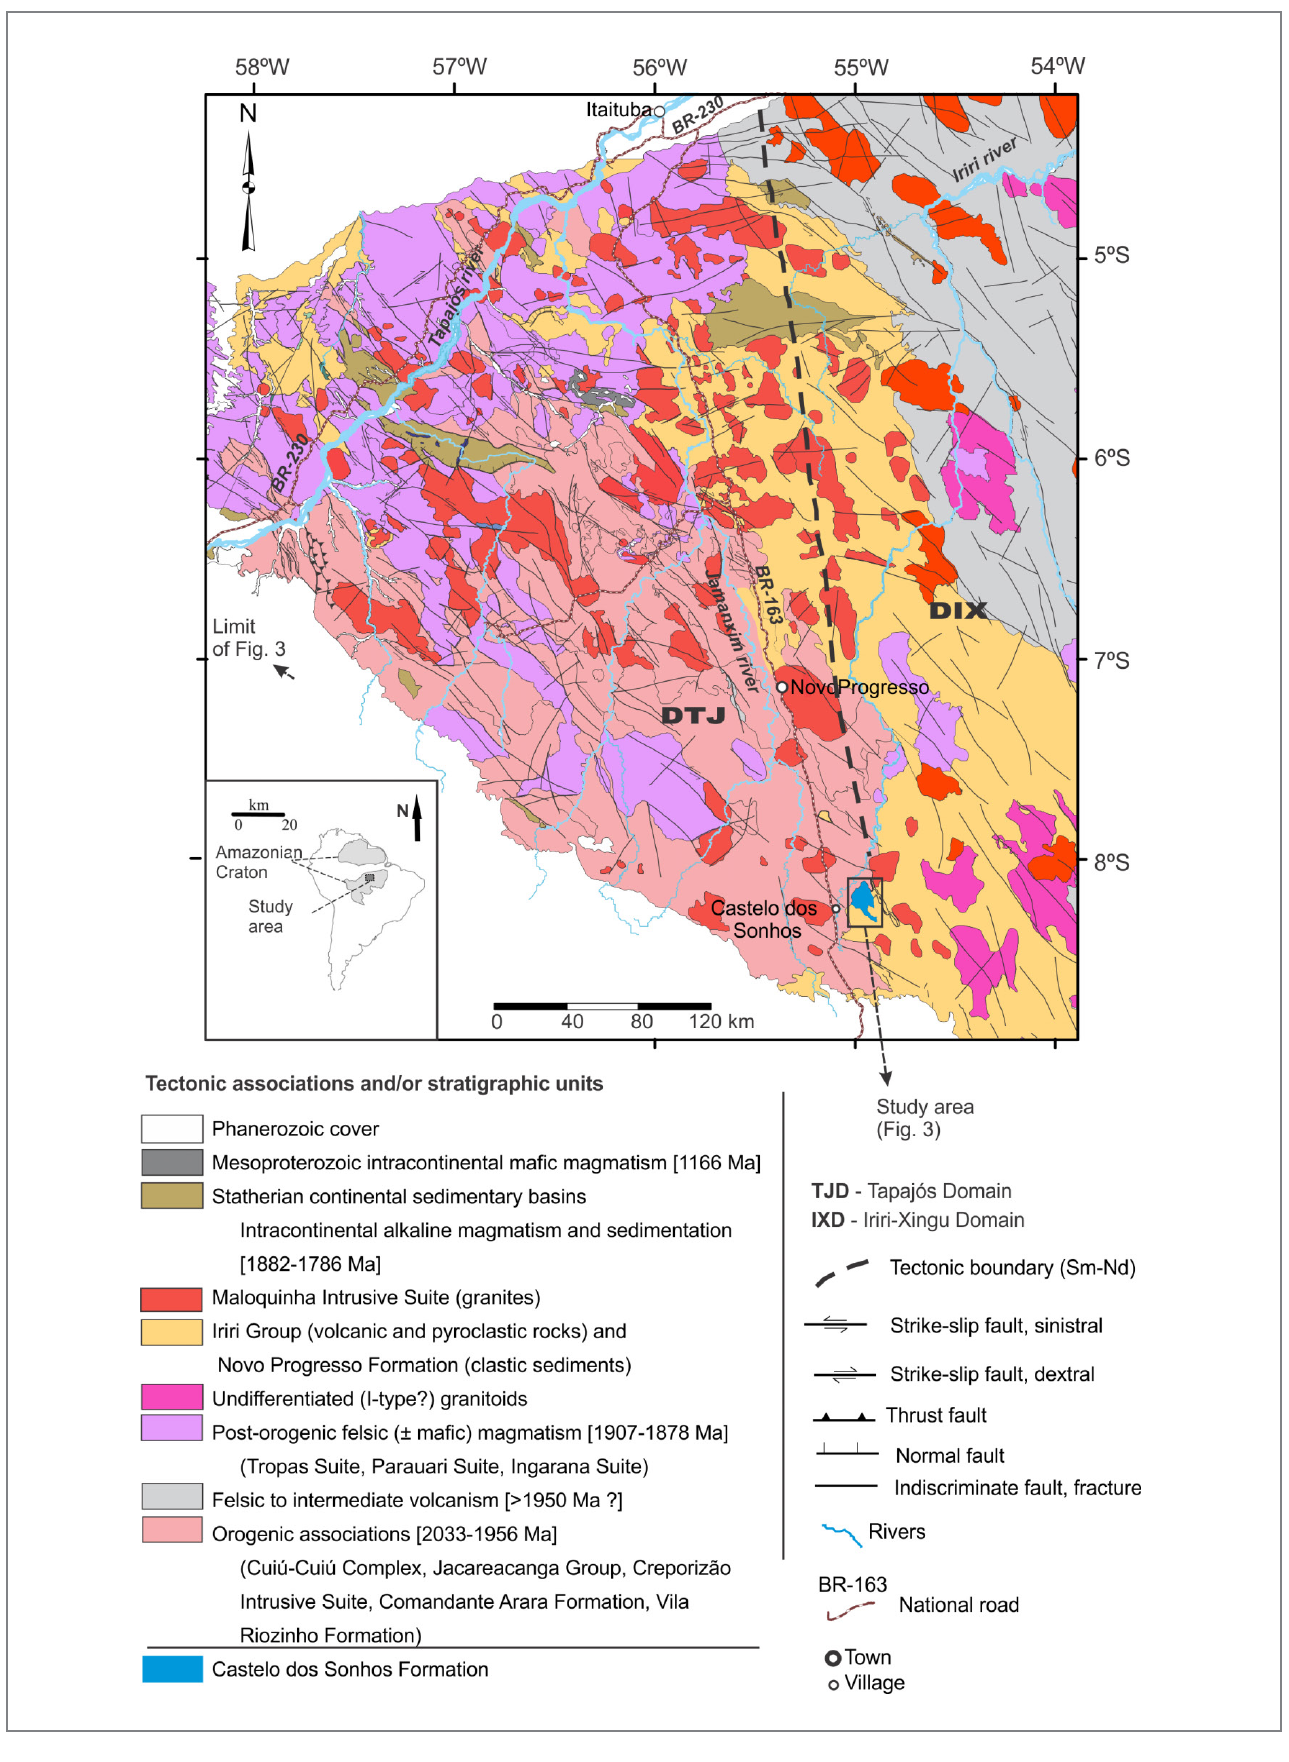
Figure 2 - Simplified geological map of the Tapajós Gold Province (adapted from Vasquez et al. 2008 and Klein et al.